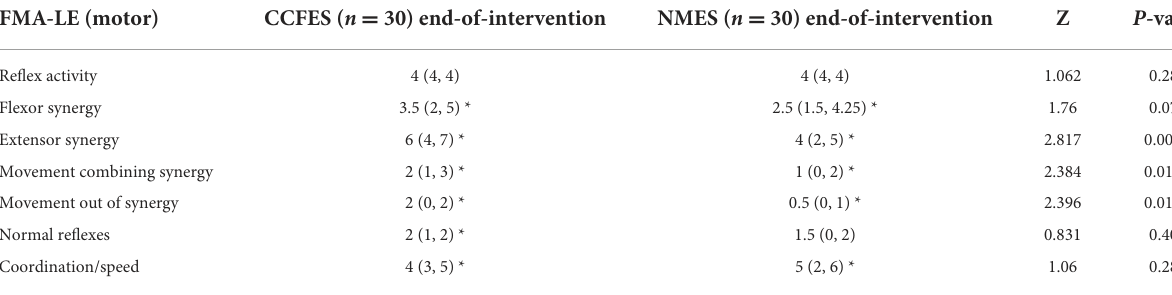
TABLE 4 Comparison of FMA-LE motor subcategories in two groups after treatment. FMA-LE (motor) CCFES ( n = 30)